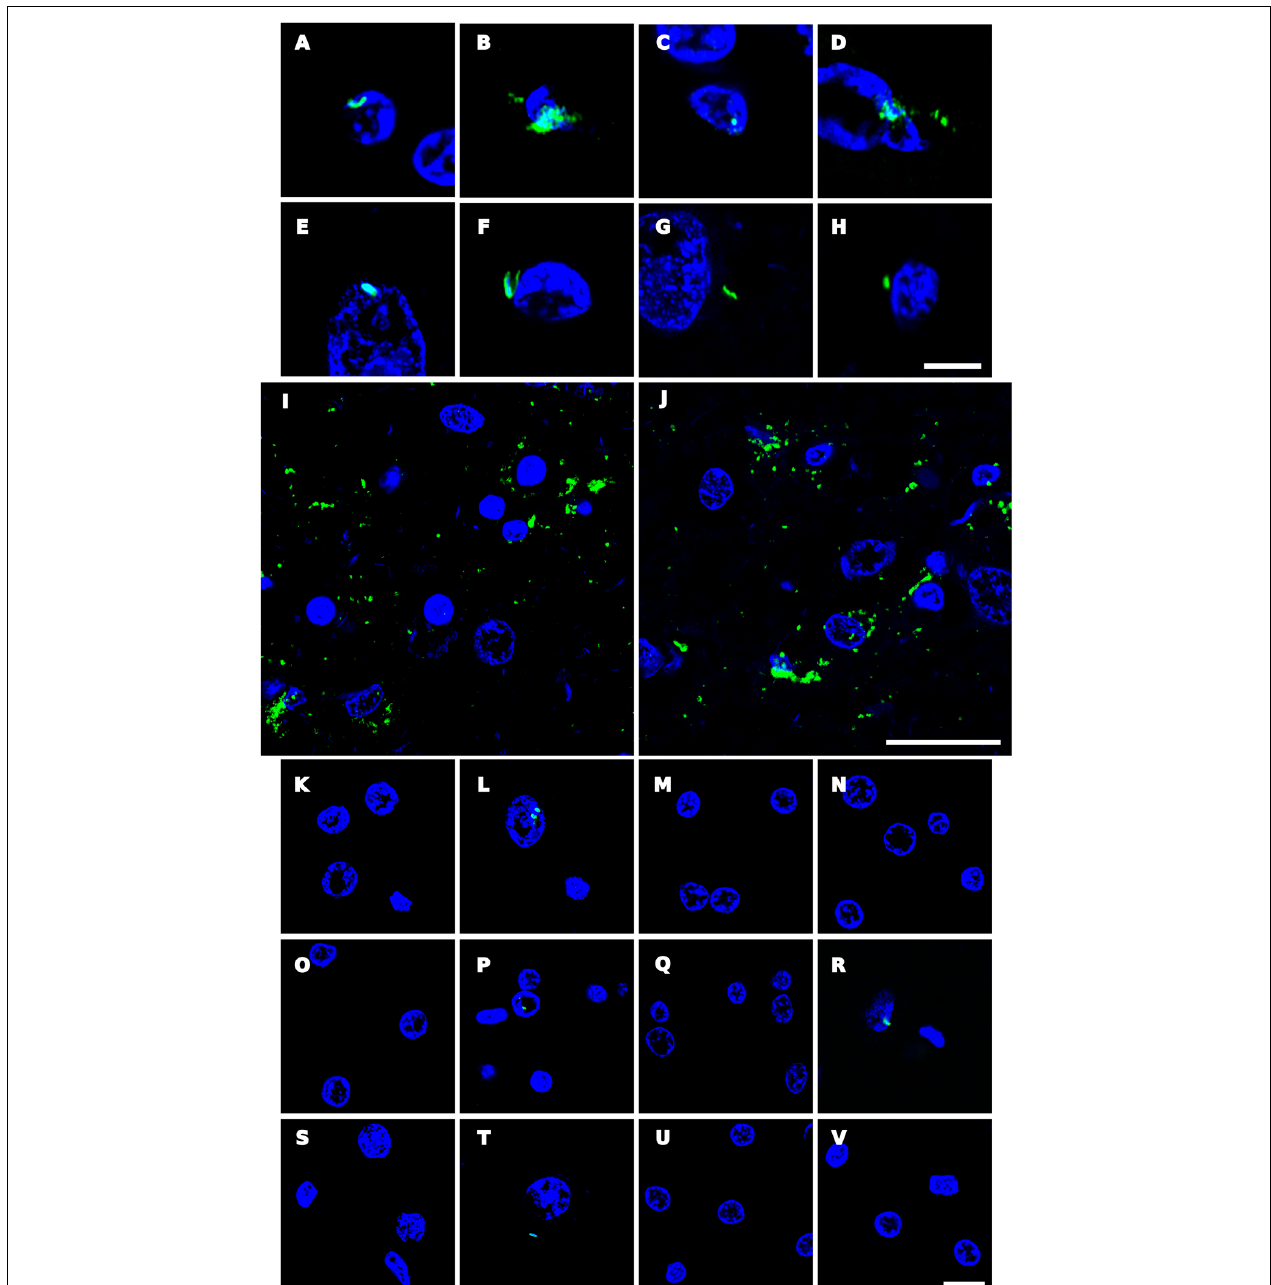
FIGURE 8 | Immunohistochemistry analysis of bacterial structures in brain sections. Paraffin-embedded ERH sections (5 µ m) were processed as indicated (see section “Materials and Methods”) and incubated with mouse monoclonal antibody against peptidoglycan at 1:20 dilution (A–D , K–M,S) . Sections were incubated with rabbit polyclonal antibody against C. pneumoniae used at 1:20 dilution (E,F,N–P,T) . Sections were incubated with mouse monoclonal antibody against Chlamydia used at 1:10 dilution (G,H,Q,U) . Sections were incubated with rabbit polyclonal antibody against Borrelia burgdorferi used at 1:50 dilution (I,J,R,V) . In all cases, DAPI staining appears in blue. (A) Patient AD2; (B,C,F) patient AD4; (D) patient AD5; (E) patient AD3; (G,I,J) patient AD7; (H) patient AD10; (K,N) control C11; (L,O) control C12; (M,P) control C13; (Q,R) control C6; (S,T) : control C10; (U) control C2, and (V) control C1. (A–J,P–R,T–V) ERH samples; (K) MD sample; (L,N,S) FC samples; (M,O) SC samples. Scale bar: 5 µ m for (A–H) ; 20 µ m for (I,J) ; and 10 µ m for (K–V)